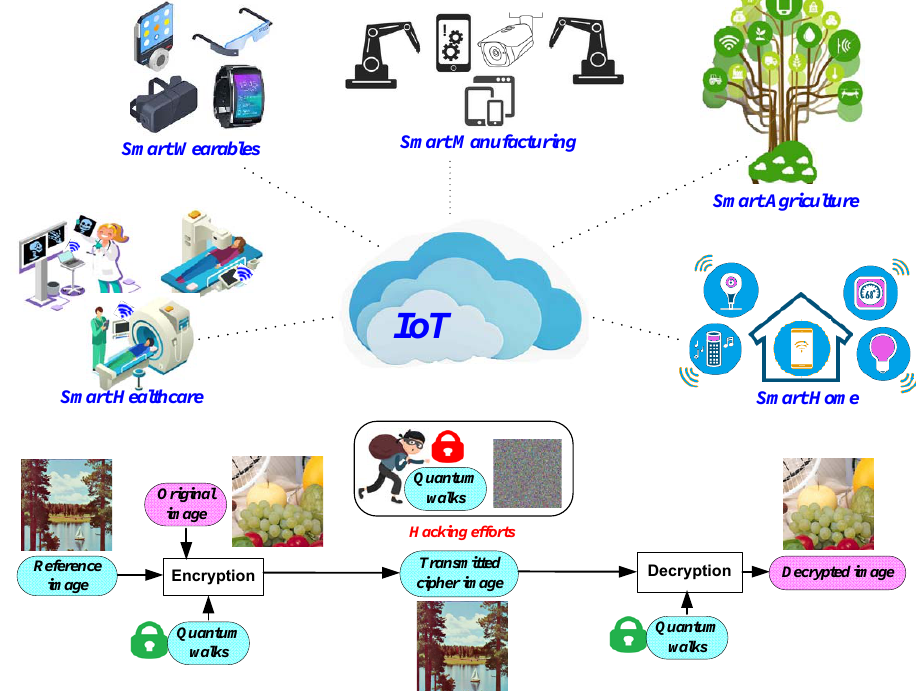
Figure 1. Illustration of framework for secure data on smart systems based on quantum